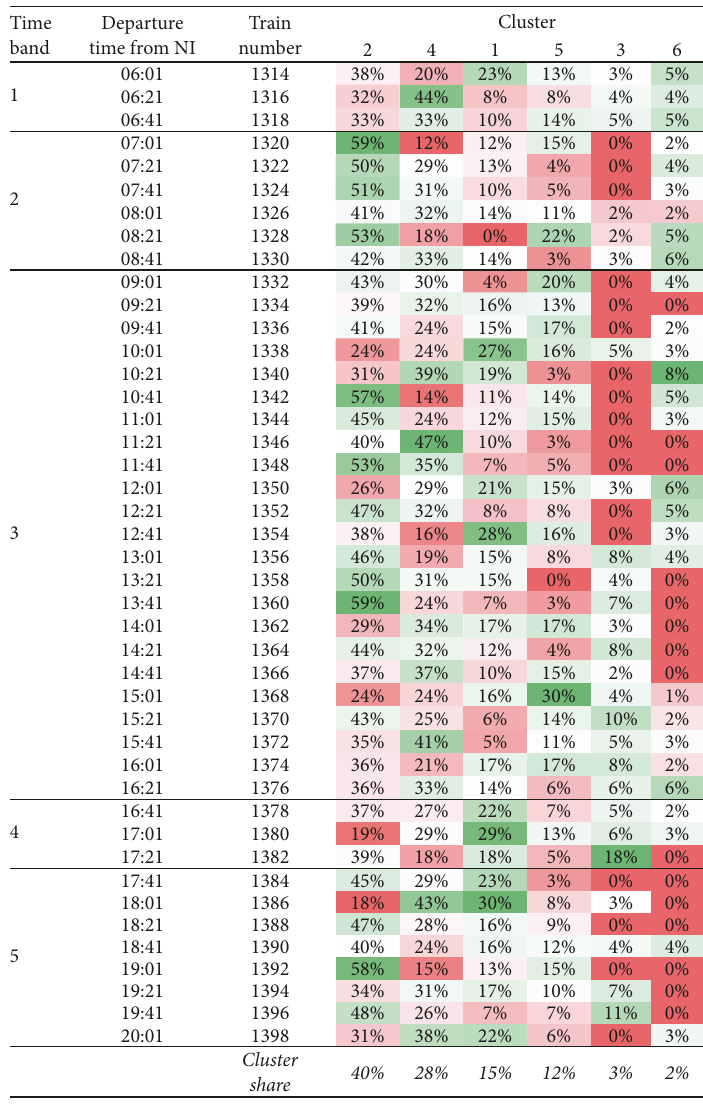
Figure 12: Southbound ØK trains. Cluster share by service ID. The color code compares the individual row’s distributions among clusters to the overall distribution among clusters reported in the last row. Clusters sorted by